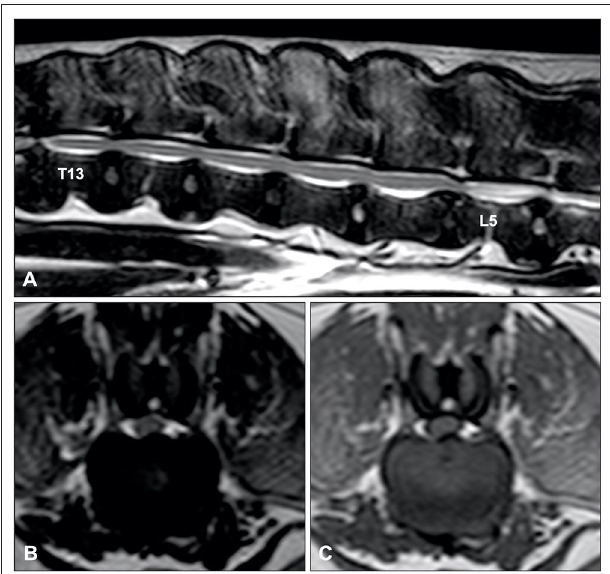
FIGURE 8 | Sagittal T2-weighted (A) , and transverse T2-weighted (B) and T1-weighted MR (C) images of a 10-year old Dalmatian with multiple IVDPs between T13 and L6. The nucleus pulposus of most intervertebral discs has maintained some T2-weighted hyperintense signal, multiple discs are affected, intervertebral disk herniations are contained within the boundaries of the intervertebral disc space, and have resulted in midline spinal cord